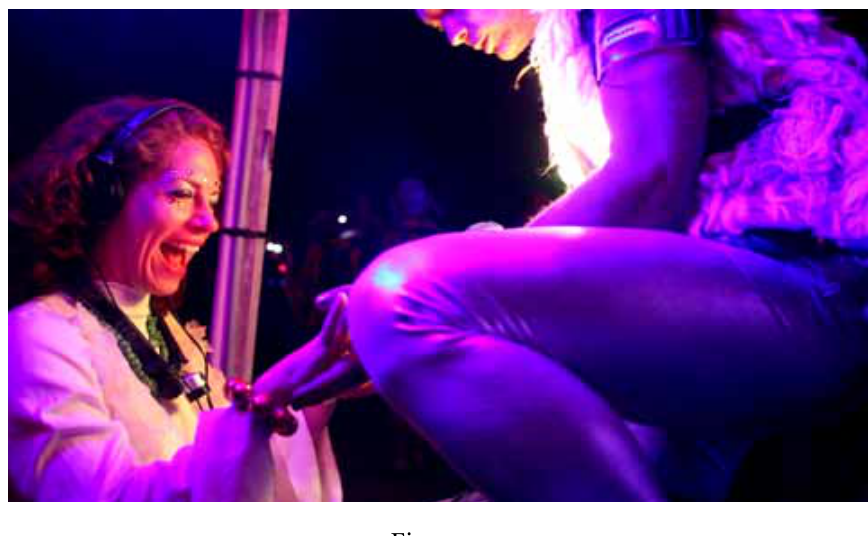
Caption: The Mediated Body in use at Burning